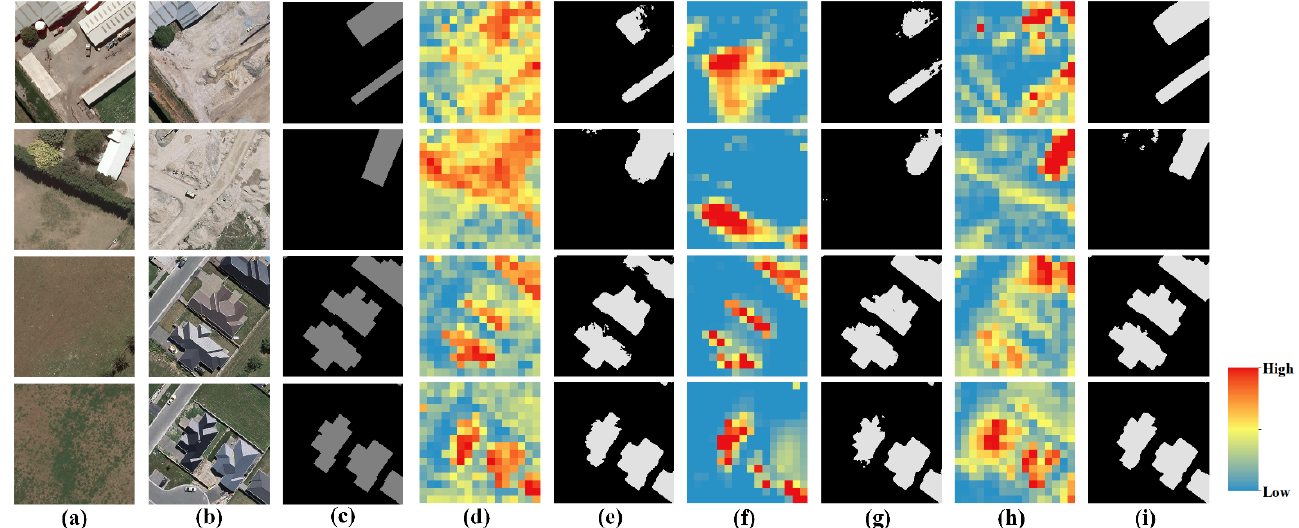
Figure 8. ( a ) Before image; ( b ) After image; ( c ) Label; ( d ) the feature heat map of MDEFNET-LL; ( e ) the result of MDEFNET-LL; ( f) the feature heat map of MDEFNET-HL; ( g) the result of MDEFNET-HL; ( h) the feature heat map of Ours; ( i) the result of Ours.